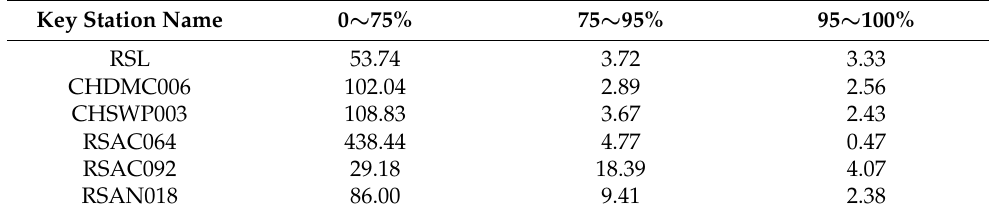
Table A1. Values of ∑ T and S t are linearly normalized according to Equation ANN